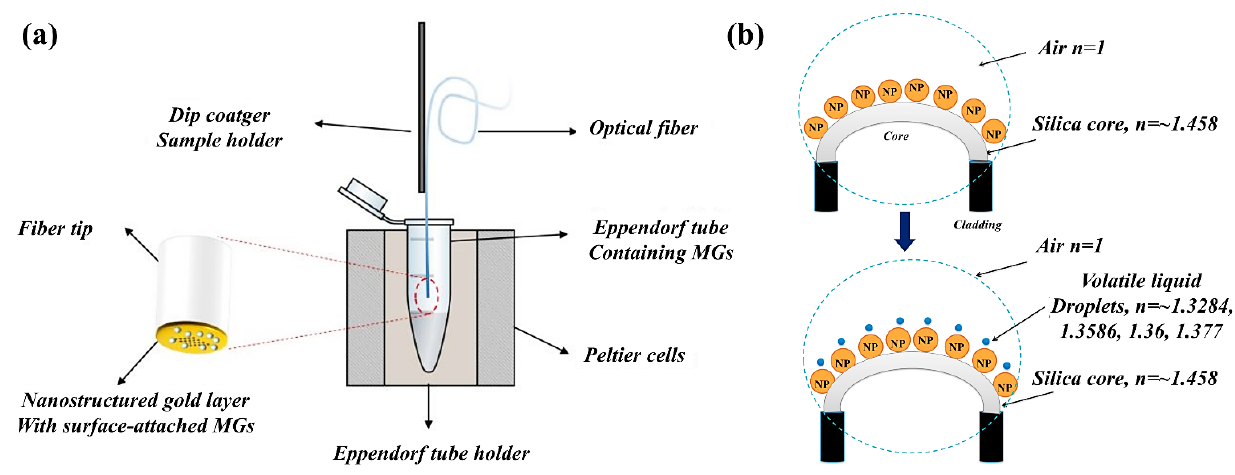
Figure 7. ( a ) Schematic of the nanopatterned fiber-optic sensor. The nanohole array was patterned on the tip of the fiber. The stimuli-responsive polymer is deposited on the nanopatterned area as shown in the figure on the right. The figure in Giaquinto et al. [62] is reprinted with permission from Multidisciplinary Digital Publishing Institute (MDPI). ( b ) Schematic of LSPR U-bent fiber-optic gasoline sensor using noble metallic nanoparticles coated on the U-bent fiber core. The figure in Saikia et al. [60] is reprinted with permission from Elsevier.